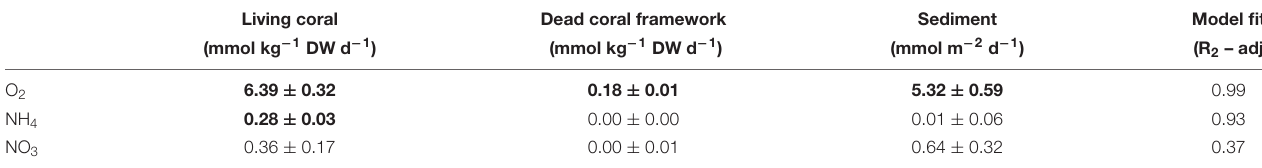
TABLE 5 | Planar regression of the benthic flux, i.e., flux = a · CWC + b · Framework + c ( n = 6), with a, “Living coral” rate, b, “Dead coral framework” rate and c , “Sediment” rate. Living coral Dead coral framework